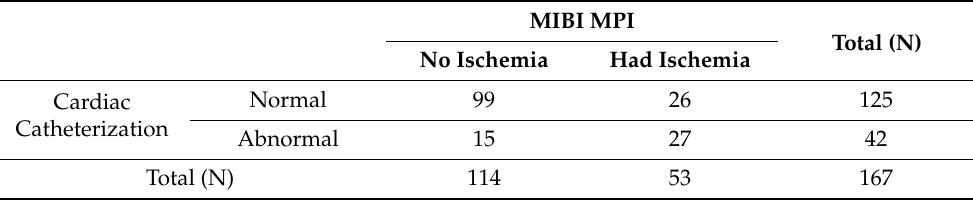
Table 2. The relationship of MPI and cardiac catheterization in patients of this